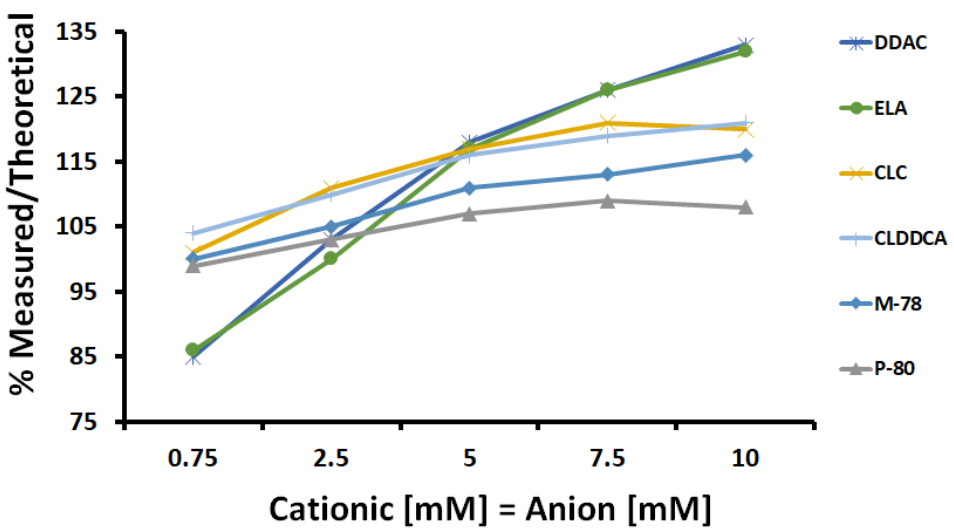
Figure 5. The ‘measured to theoretical conductivity ratio’ for each SLES:cationic preservative mix (1:1 molar ratio) at the concentration range of 0.75–10 mM (at 25 °C).